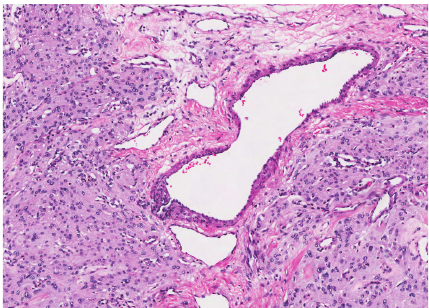
Figure 10: Desmoplastic trichoepithelioma: macroscopic picture showing an ulcerative nodular lesion with raised rolled edges features which mimic SCC or BCC.